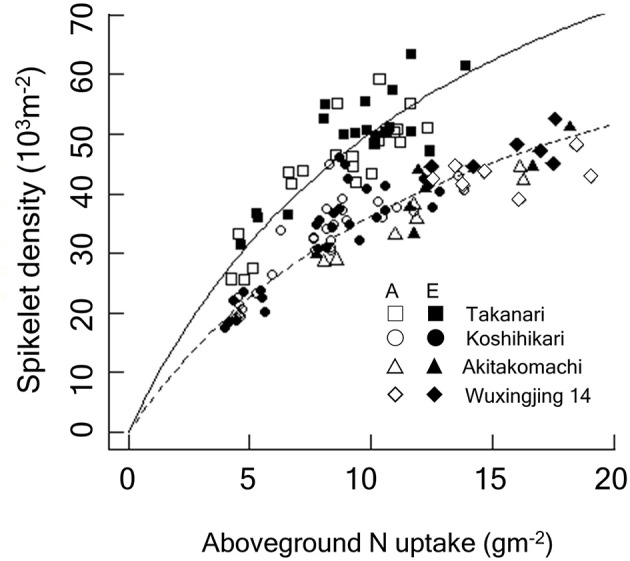
Relationship between spikelet density and crop N accumulated by the heading stage of Koshihikari and Takanari grown at the Tsukuba FACE for 3 years (2012–2014). Additionally, data from the Shizukuishi FACE, Iwate, Japan (“Akitakomachi”) and from the Wuxi FACE, Jiangsu, China (“Wuxianjing 14”) are shown (Kim et al., 2003; Yang et al., 2006). A linearized form of the Michaelis-Menten type rectangular hyperbola function was fitted to the data by the ordinary least square method. The regression lines were significantly different between Koshihikari and Takanari (P < 0.001) and between Takanari and the rest (P < 0.001). A, A-[CO2]; E, E-[CO2]. In the figure, regressions reconverted to the original form are shown: Solid, Takanari, y = 120.5x/(13.98 + x), R2 = 0.804, P < 0.001; Dashed, the rest, y = 90.11x/(14.89 + x), R2 = 0.876, P < 0.001.